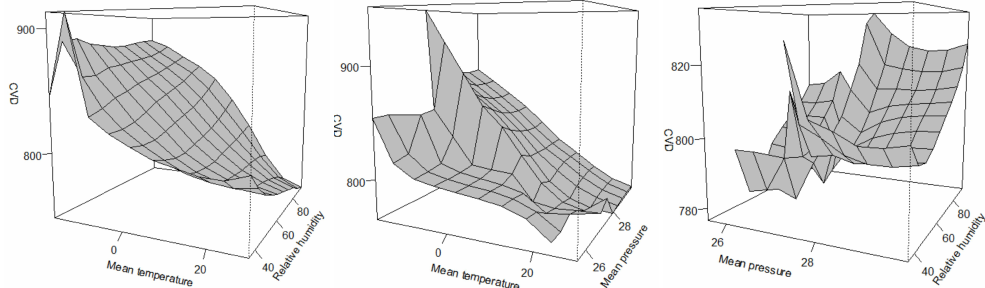
Figure 2. Three-dimensions scatterplot of mean temperature, relative humidity and CVD ( left ), mean temperature, mean pressure and CVD ( middle ), and mean pressure, relative humidity and CVD ( right ).